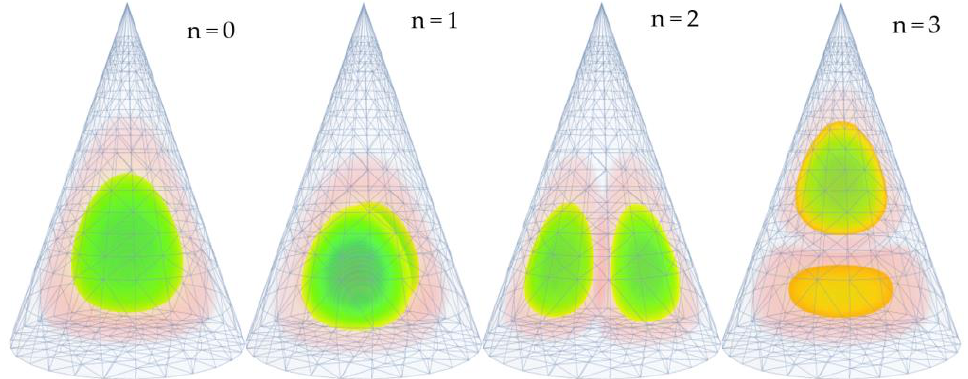
Figure 2. Probability distribution of an electron (hole) over conical QD for the first four states. The color scale in the figure is from green (high density) to red (low density).